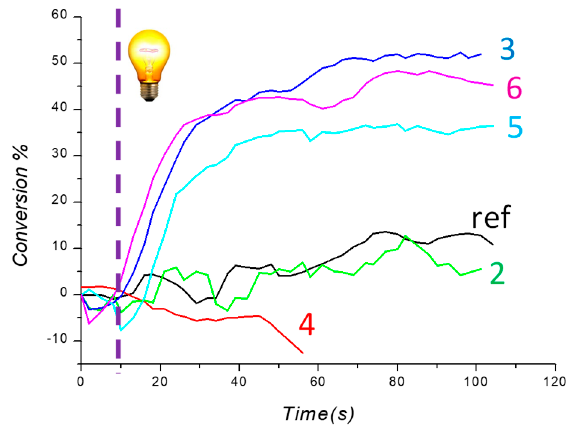
Figure 2. Photopolymerization profiles (epoxy function conversion vs. irradiation time) measured by RT-FTIR for the photoinduced polymerization of EPOX using the different iodoniums ( 2 – 6 ) 1% w / w ; the polymerization profile obtained with the reference is noted ref; thin samples (25 μ m) under air, upon LED@365 nm irradiation (the irradiation starts at t = 10 s, 500 mW/cm 2 ).